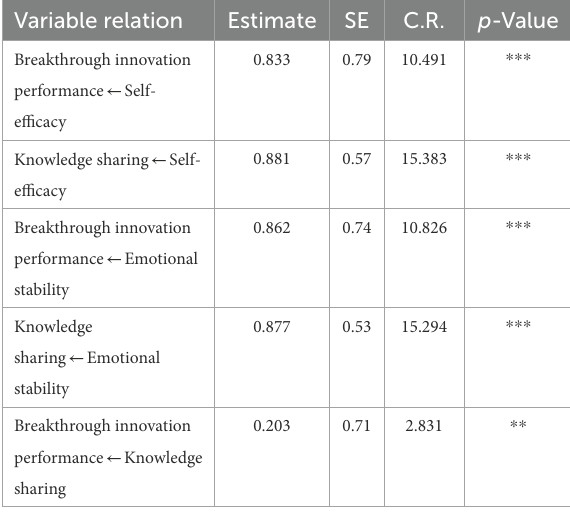
TABLE 5 Path regression coefficients of research